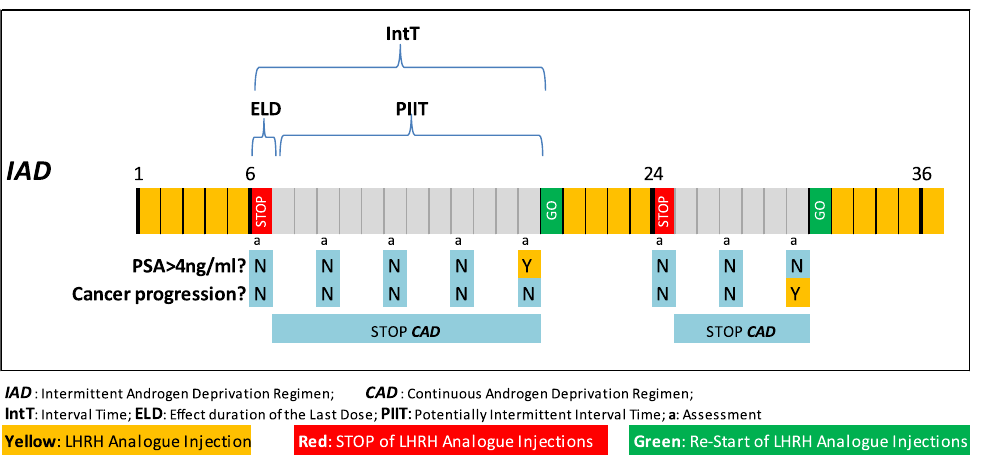
Figure 1. Representation of the parameters needed to identify the intermittent periods in a 36-month scenario.